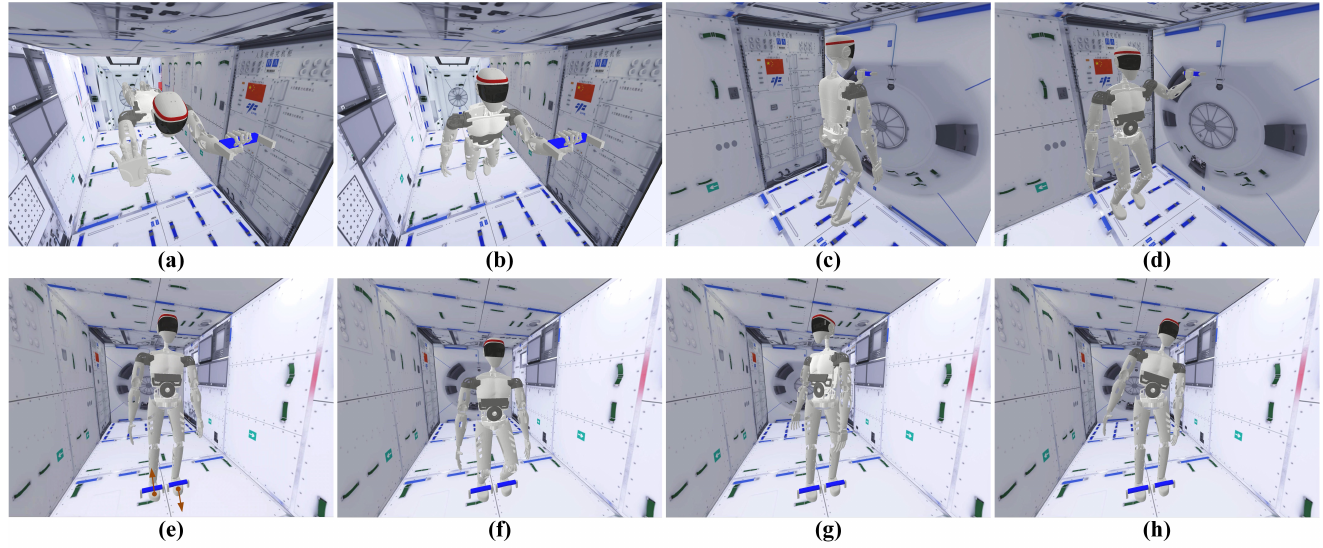
Figure 7. Taikobot can dock with handrails ( a – d ) and foot restraints ( e – h ) and locomote locally in docking